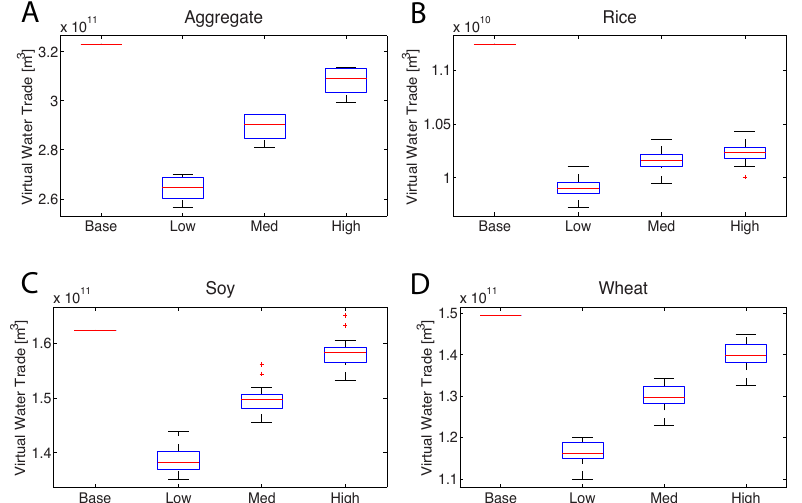
Fig. 5. Total VWT by commodity trade and yield scenario. ( a ) Total VWT associated with the trade of rice, soy, and wheat commodities; ( b ) total VWT associated with the rice commodity trade only; ( c ) total VWT associated with the soy commodity trade only; and ( d ) total VWT associated with the wheat commodity trade only. The x axis in each plot indicates the yield scenario: “Base” indicates the baseline scenario (i.e., 2001), “Low” indicates the low-productivity scenario, “Med” indicates the medium-productivity scenario, and “High” indicates the high-productivity scenario. All future climate change scenarios are for the year 2030. Box and whisker plots for each yield scenario indicate the median data value (red line), the quantiles of the data (blue box), and any data outliers (red stars).